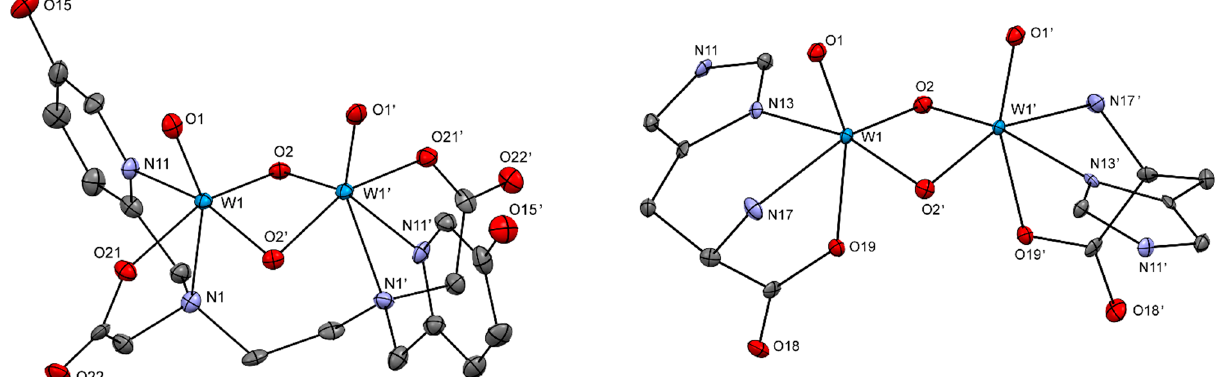
Figure 6. ORTEP view of complexes 4 ( left ) and 5 ( right ) with atom labeling scheme. Symmetry related atoms are labeled with X’ using the following symmetry transformations: -x, 1-y, z in 4, and -x, y-x, 5/3-z in 5 . The thermal ellipsoids have been drawn at 50% probability level. Hydrogen atoms as well as solvent molecules are omitted for clarity. Table 1. Selected bond lengths (Å) and angles ( ◦ ) for complexes 2a , 3 , 4 , and Ba[W 2 O 4 (EDTA)]